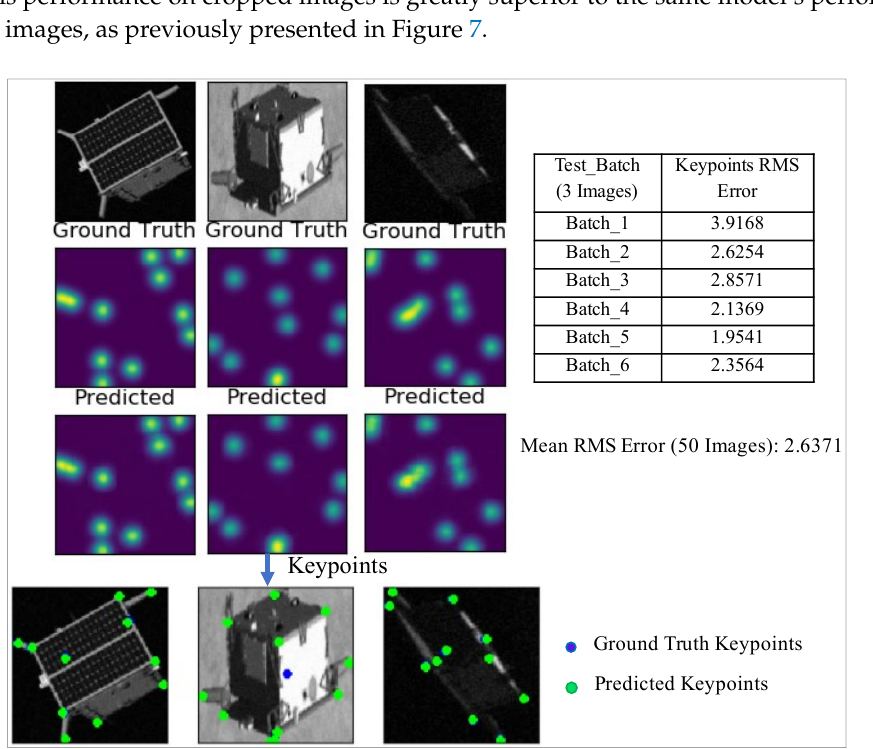
Figure 10. U-Net Model Keypoint Detection Performance on Cropped